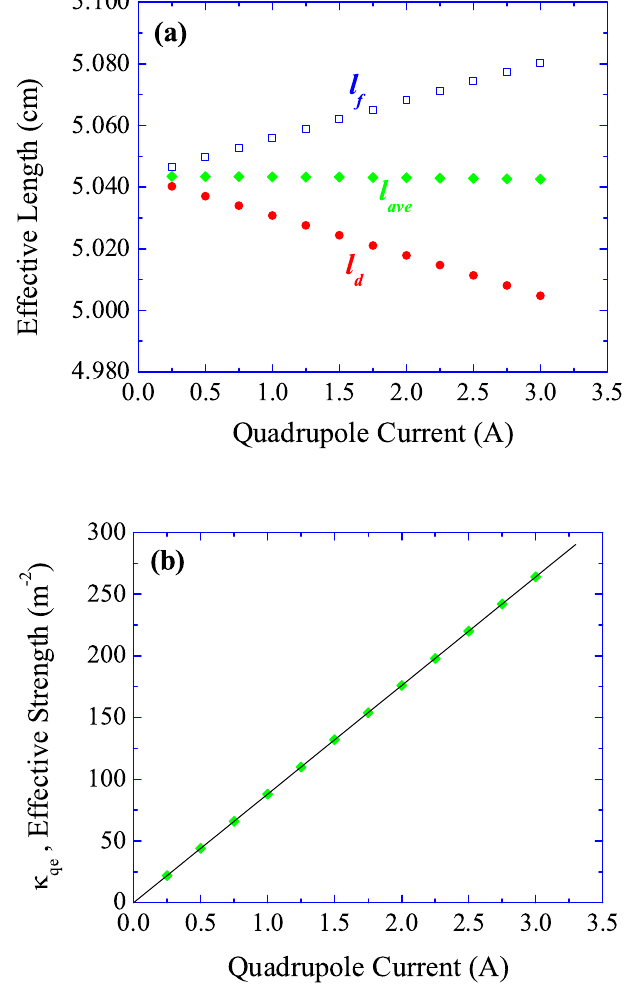
FIG. 3. (Color) Characterization of effective hard-edge model of (2nd generation) UMER magnetic quadrupole: (a) effective lengths in the focusing and defocusing planes and average values as a function of quadrupole current, and (b) effective average strength as a function of quadrupole current [see Eq.